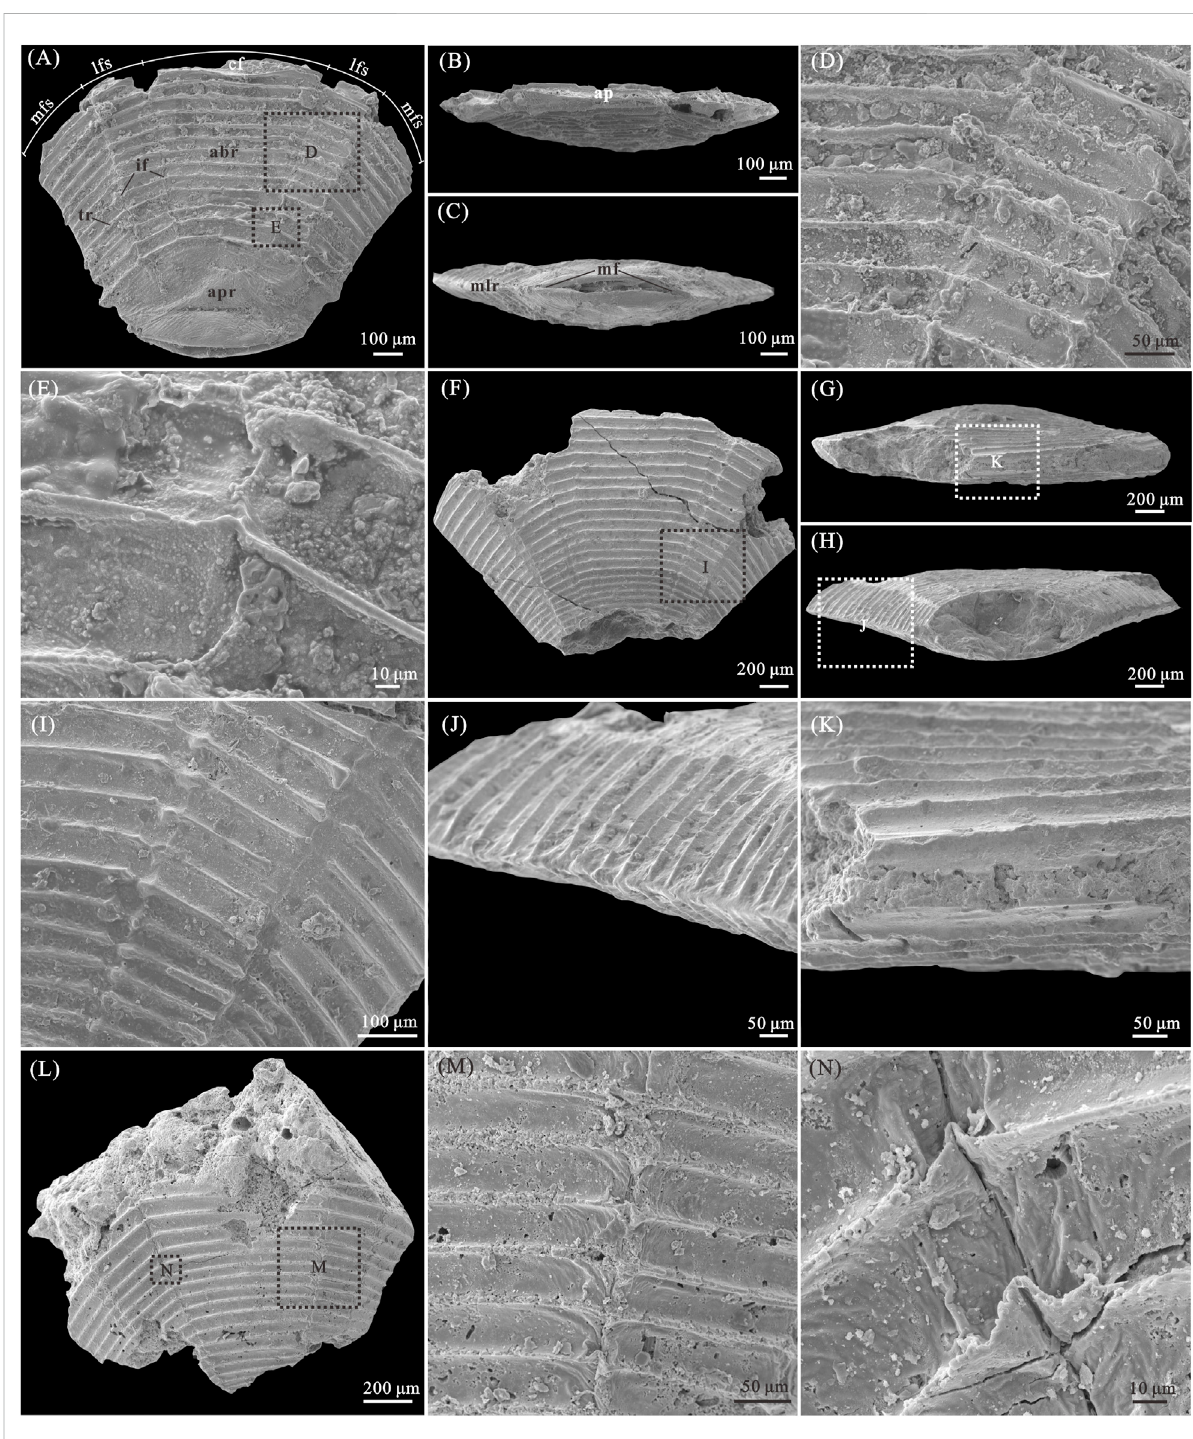
FIGURE 2 Decimoconularia anisfacialis n. sp. from the Kuanchuanpu Formation (Cambrian Fortunian Stage) of southern Shaanxi Province, China. (A,F,L) KP-45-1, SN114-k32-79, and SN047-K30-76, respectively. (B – C,G – H) Apertural and apical views of (A,F) , respectively. (D,E) Magni fi ed views of (A) , showing the trochoidal transverse ribs, adjacent faces separated by interfacial (longitudinal) furrows, and transverse ribs puckered along the interfacial (longitudinal) furrow. (I,J,K) Magni fi ed views of (F,G,H) respectively, showing adjacent faces separated by interfacial (longitudinal) furrows, two sides separated by marginal longitudinal ridges, and the very narrow aperture. (M,N) Magni fi ed views of (L) , showing the concave interspace between adjacent transverse ribs, fi ne irregular wrinkles within the interfacial (longitudinal) furrow, and puckering of the transverse ribs within and along the interfacial (longitudinal) furrow. Abbreviations: abr=abapical region; ap=aperture; apr=apical region; cf=central face; if= interfacial (longitudinal) furrow; lfs=lateral faces; mf=marginal furrow; mfs=marginal faces; mlr=marginal longitudinal ridge; tr=transverse